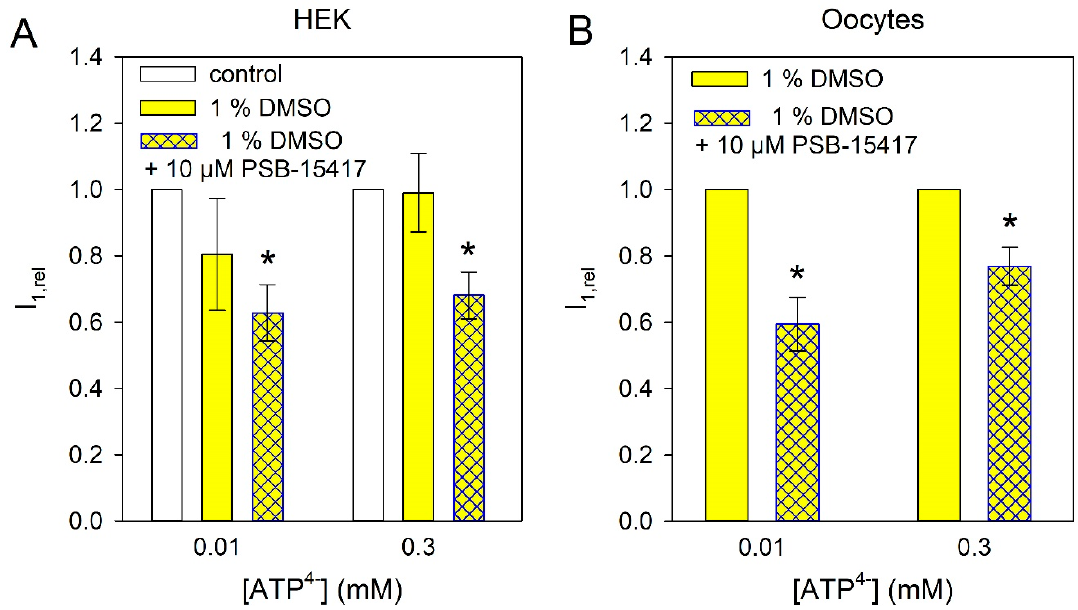
Figure 3. Effect of PSB-15417 on P2X7R-dependent ion currents. Currents were measured in HEK cells expressing hP2X7 ( A ) and in Xenopus oocytes expressing mP2X7 ( B ). Means ± SEM of 5–12 cells. Significant differences from the control are marked by asterisks.